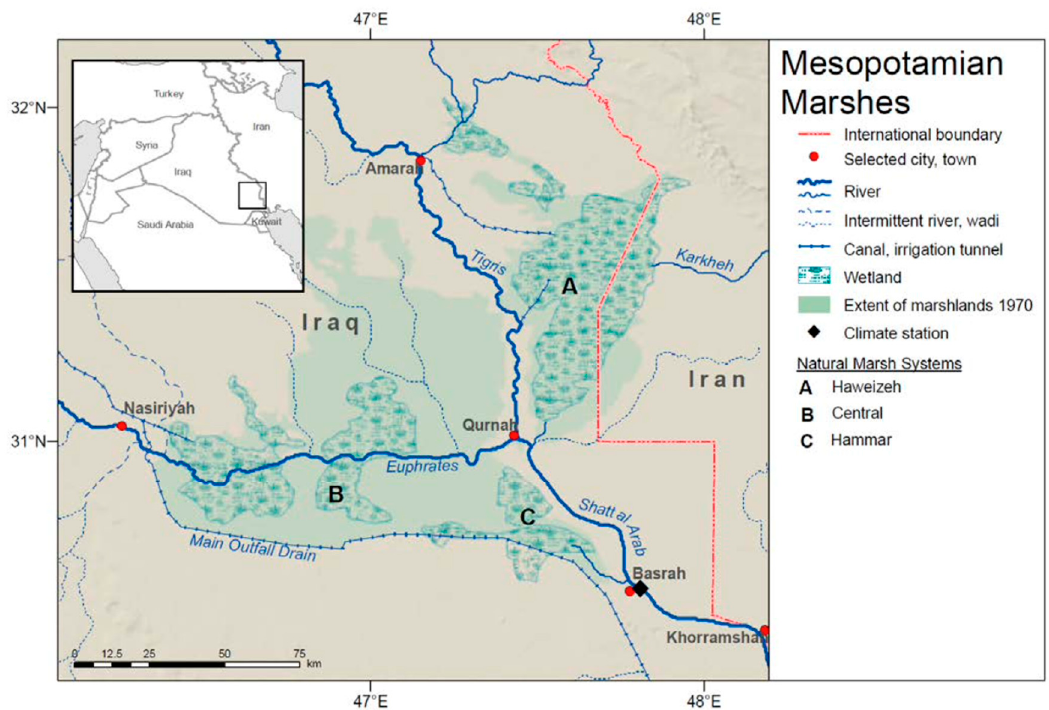
Figure 7. Location of the Mesopatamian marshes in the Tigres-Euphrates-Kuran Delta showing the decrease in wetland area since 1979 (Modified from [76]).